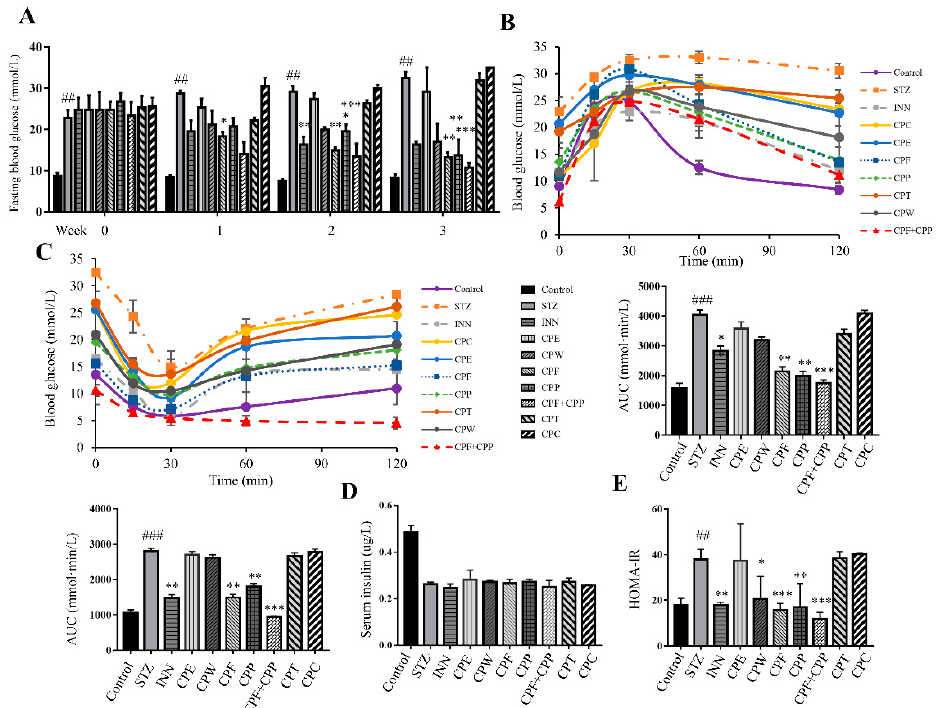
Figure 2. CPF (flavonoids fraction from C. paliurus leaves) and CPP (polysaccharide fraction from C. paliurus leaves) improve insulin sensitivity in STZ (streptozotocin)-induced diabetic mice. ( A ) Fasting blood glucose levels of all groups. ( B ) Glucose tolerance test was performed after 2-week CP fractions treatment. AUC of each group was calculated. ( C ) Insulin tolerance test was performed after 3-week CP fractions treatment. AUC (area under curve) of each group was calculated. ( D ) The serum insulin levels were determined after 18 h fasting. ( E ) The homeostasis model assessment of basal insulin resistance (HOMA-IR). n = 6. ## p < 0.01, ### p < 0.001, STZ vs. control, * p < 0.05, ** p < 0.01, *** p < 0.001, STZ vs. treatment.